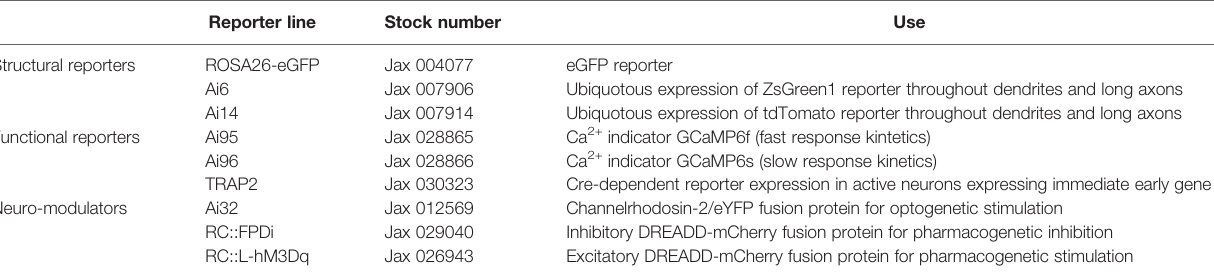
TABLE 3 | Examples of Cre-dependent reporter mouse lines for neuronal